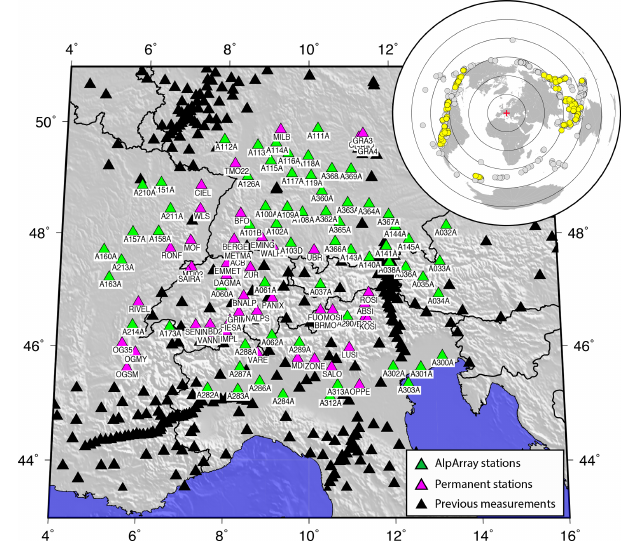
Figure 2. Topographic and political map of the central Alpine re- gion showing broadband seismic stations (triangles) whose data were analysed in this study, including AlpArray temporary stations (green), permanent stations (magenta), and stations with previous SKS measurements (black). Inset shows the location of all earth- quakes recorded between 2015–2019 (grey circles), those analysed in this study (yellow circles), and the centre of our study area (red